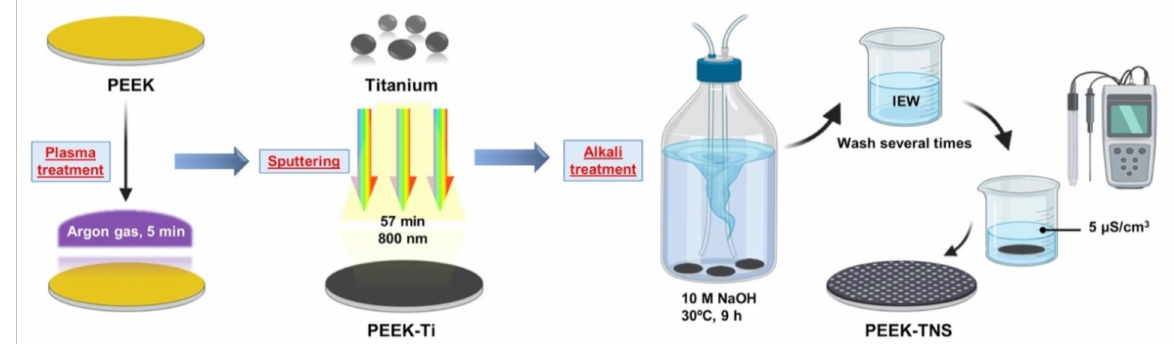
Figure 7. Schematic illustration of the PEEK-Ti and PEEK-TNS sample processing procedures. Prior to titanium film deposition, the PEEK substrates underwent argon plasma treatment at 30 W and 60 Pa for 5 min. The titanium films of 800 nm thickness were then deposited on the plasma-treated PEEK by the plasma sputtering process. The titanium-coated PEEK samples were denoted by PEEK- Ti. The PEEK-Ti samples were immersed in 10-M NaOH at 30 ◦ C for 9 h and rinsed several times with ion-exchanged water until the solution reached a conductivity of <5 µ S/cm 3 for the fabrication of porous nanonetwork structures on the surface. The PEEK samples with porous nanonetwork structures were denoted by